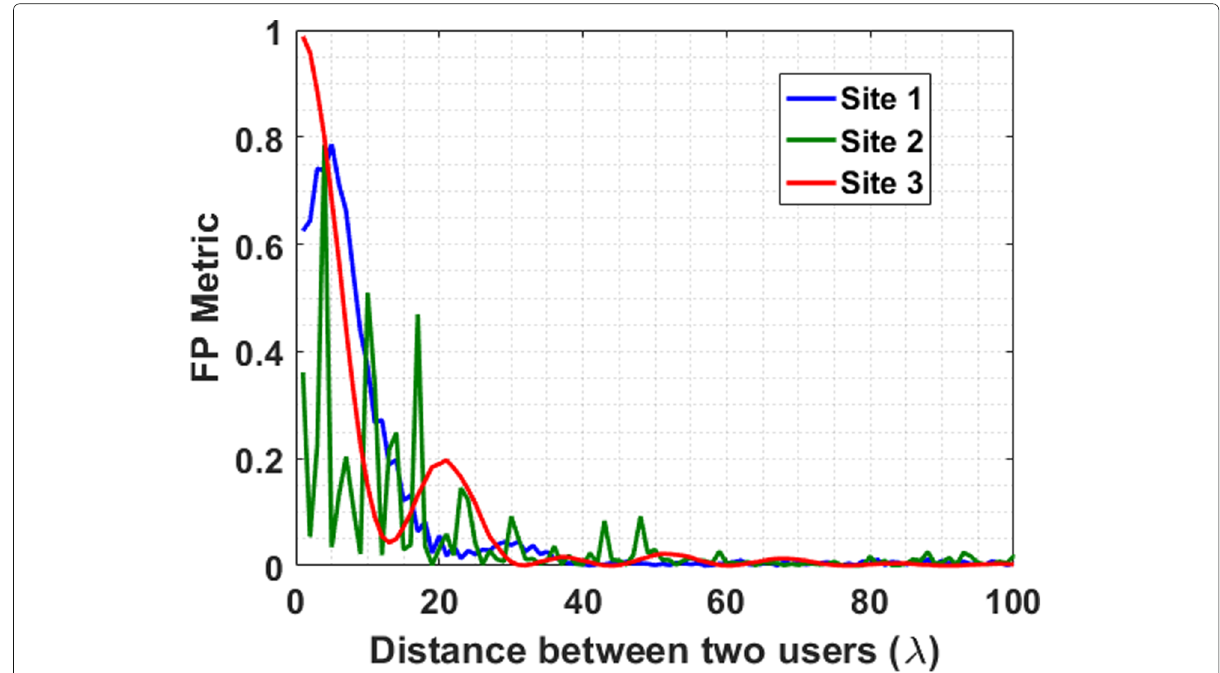
Fig. 8 Minimum distance required between the two users to obtain FP-like